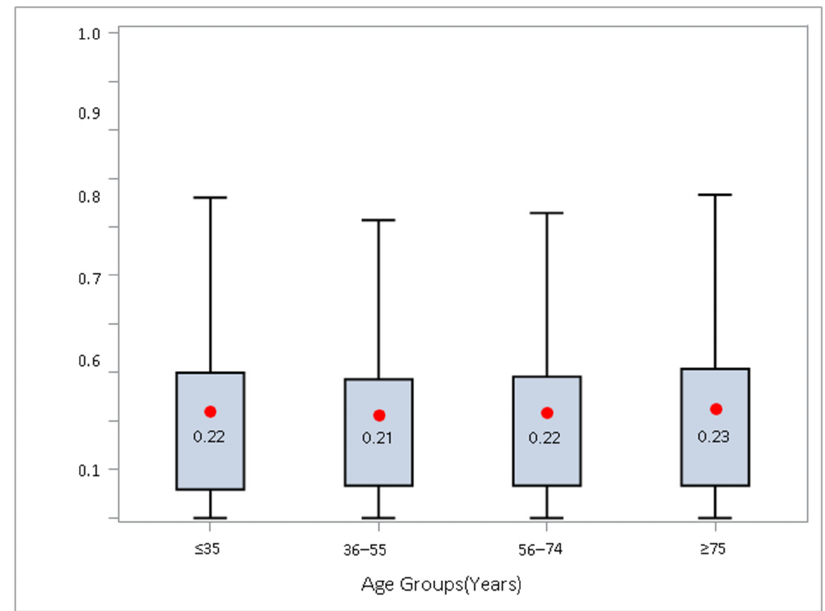
Figure 2. Mean LNR ratio by age groups with at least one lymph node examined. After adjusting for tumor location, grade, histology, pathological T stage, and neoad- juvant chemotherapy the TLH was increased with decreasing age of the patient. The larg- est difference was noted when comparing the youngest cohort of patients (those ≤ 35) who had an incident rate ratio (IRR) 1.56 (95% CI 1.54, 1.59) times than that of patients age ≥ 75 (Table 3). The estimated LNR was only slightly higher among younger patients after ad- justing for covariates, with the IRR in patients ≤ 35 of 1.16 (95% CI 1.13, 1.2) when com- pared to patients ≥ 75 (Table 3). Additional factors found to impact LNR were grade, his- tology, and pathologic T stage of the tumor. LNR directly increased as the grade of the tumor became more undifferentiated, with poorly differentiated tumors having the larg- est impact on LNR 1.60 times higher than well differentiated tumors (CI 95% 1.56, 1.62). More aggressive histologies were found to correlate with increased LNR, with signet ring having the largest impact, 1.56 times higher than in adenocarcinoma (CI 95% 1.52, 1.61). Pathologic T stage had the largest correlation with LNR with T4 tumors having 2.13 times increased LNR (Table 3). Table 3. Negative binomial regression, LNR and TLH.